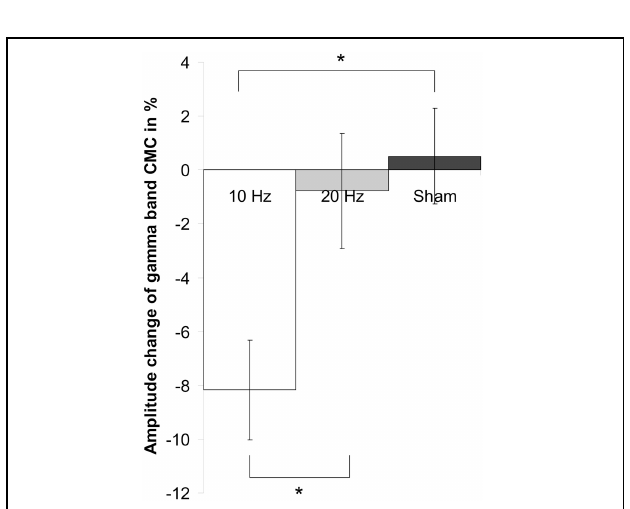
FIGURE 5 | Main effect of factor stimulation on low gamma CMC. Shown are relative changes of contralateral CMC amplitude in the low gamma band during isometric contraction after 10Hz, 20Hz and sham tACS collapsed across the two post tACS measurements. After 10Hz tACS CMC amplitude was significantly lower as compared to 20Hz and sham stimulation. Asterisk denotes significant p -values < 0.05. Error bars indicate standard error of mean.